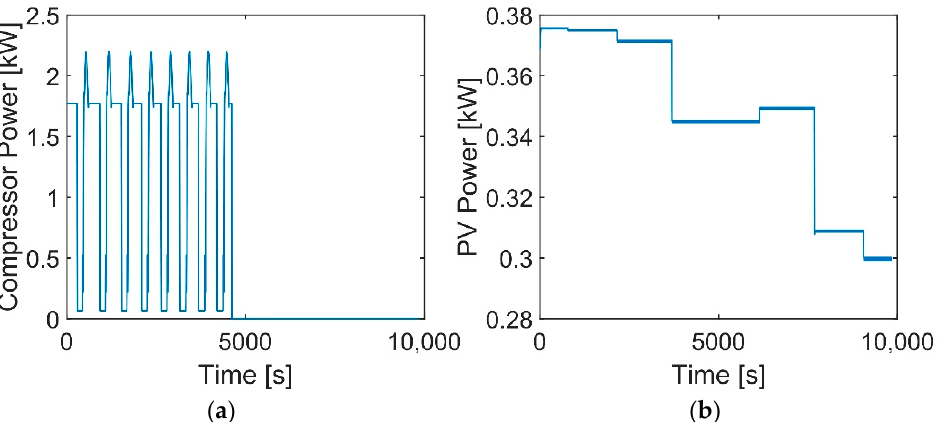
Figure 5. Power required by the refrigeration unit ( a ) and solar power available ( b ).